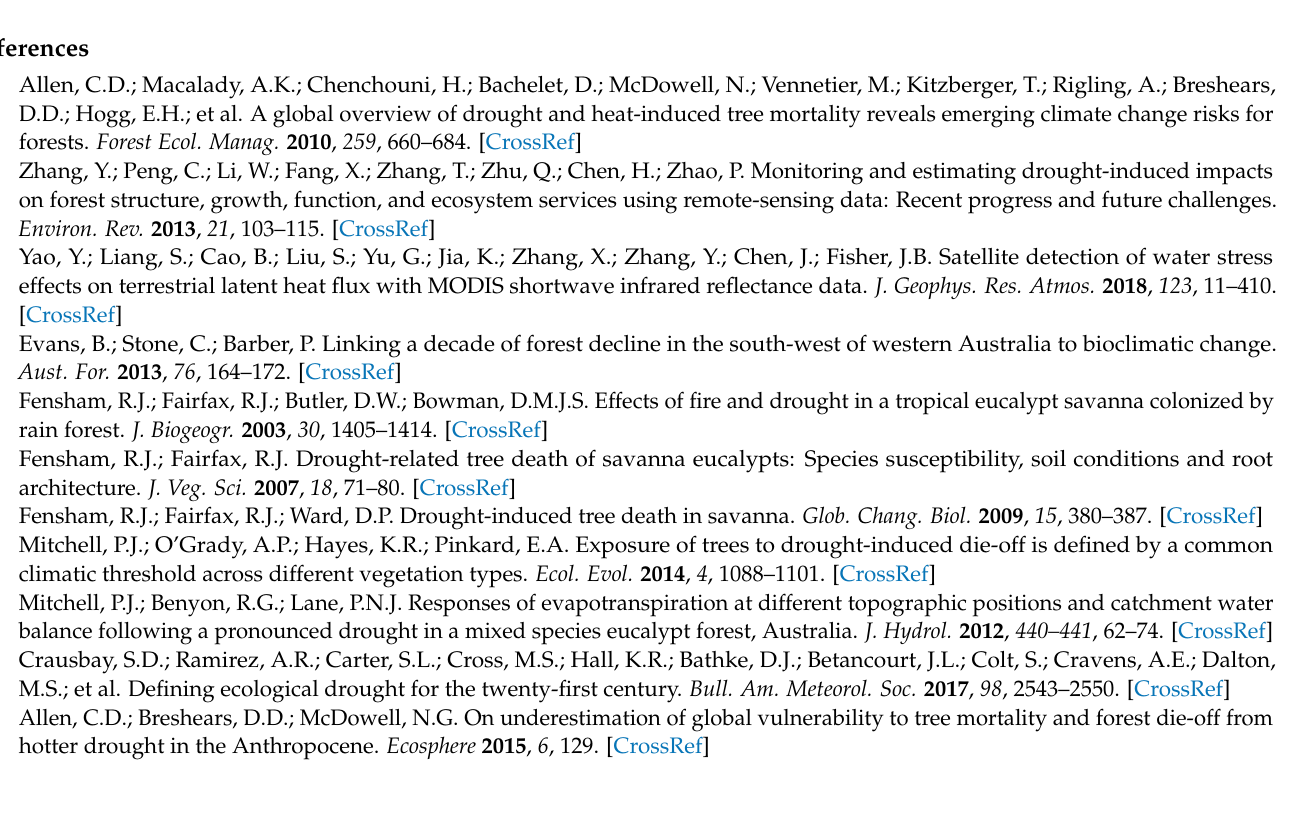
samples of training and testing data, (a) R 2 (Actual vs. Predicted AWRA-L soil moisture), (b) RMSE (Actual vs. Predicted AWRA-L soil